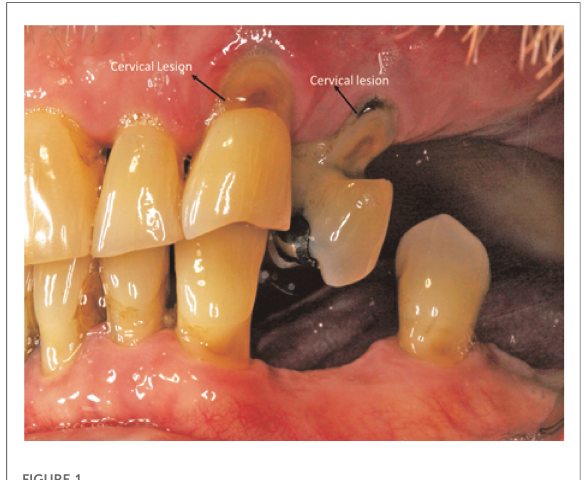
FIGURE 1 Non-carious cervical lesions.